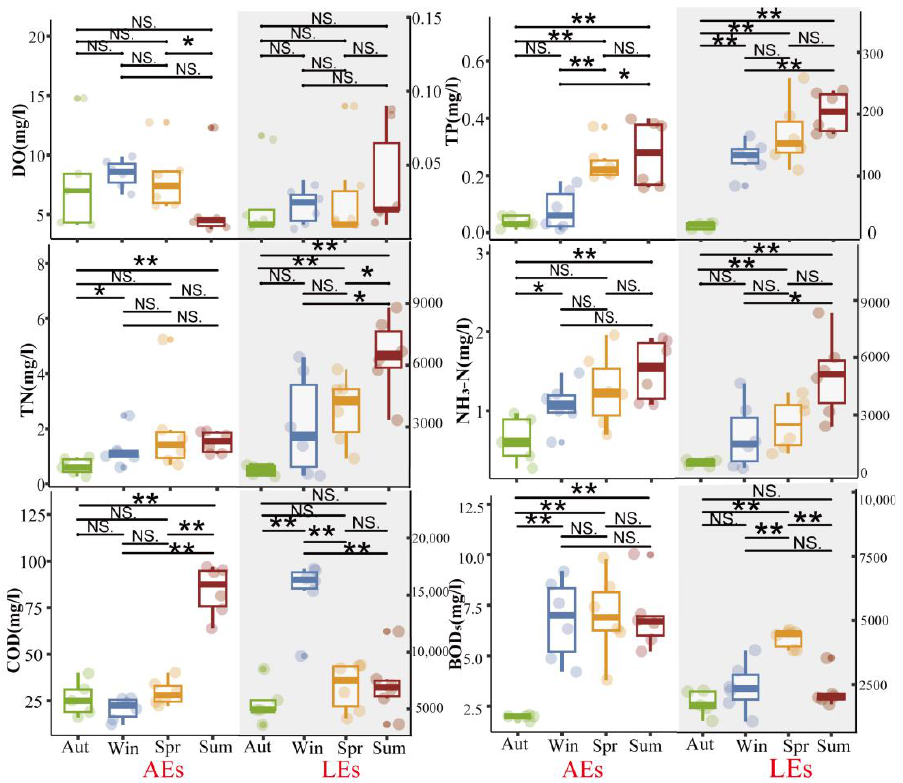
Figure 2. Seasonal variation in water quality parameters in AEs and LEs, seasonal difference U-test for AEs and LEs; * represents p < 0.05, ** represents p < 0.01. NS. stands for no seasonal variation.